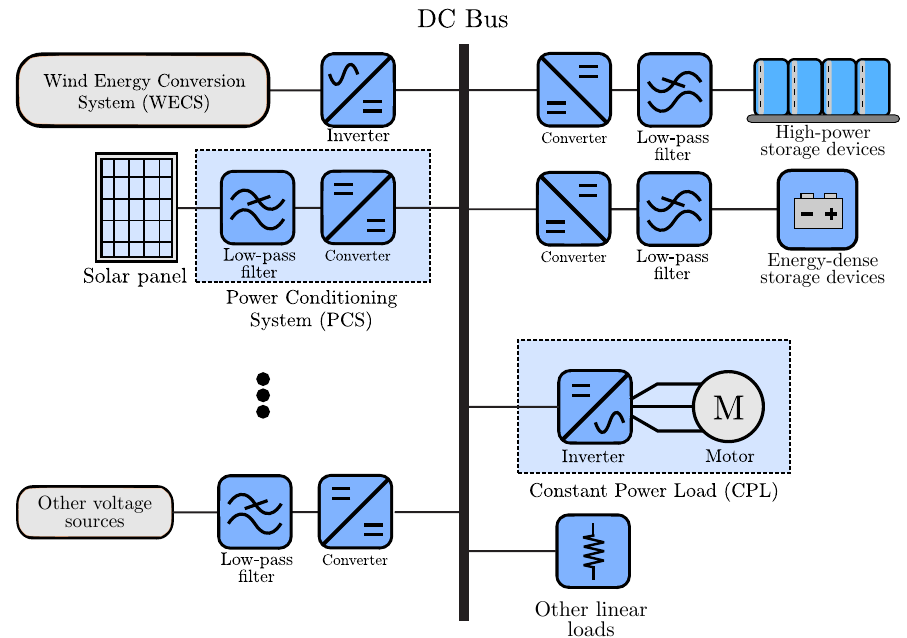
Figure 1. Illustrative representation of a DC microgrid combining renewable modules, non conventional storage modules and constant power